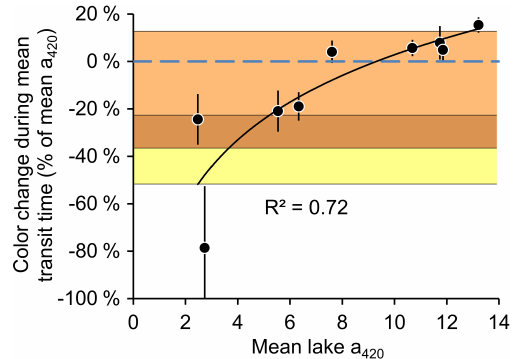
Figure 4. Percent change in epilimnetic color ( a 420 ; filled circles) during water transit through nine boreal lakes plotted over a gradi- ent of increasing mean lake color ( y =0.39ln( x ) − 0.87, p < 0 . 01). The change in color ( ± error bar) is based on the in situ data re- gression slopes ( ± SE) from Table S1 multiplied by the mean water transit time in each lake and expressed in proportion to lake mean a 420 . The blue line denotes zero change. For the significance of the individual color loss terms, see the original epilimnetic a 420 regres- sion models in Table S1 or Fig. S5 in which the lakes are aligned in the same order as here, from clear to brown. For a qualitative comparison, the yellow and brown areas, respectively (overlapping in the dark brown area), indicate ranges in a 420 change from the beginning to the end of light ( ∼ 100MJ absorbed per m 3 of water) and dark (1.2 years of incubation) experiments performed in the